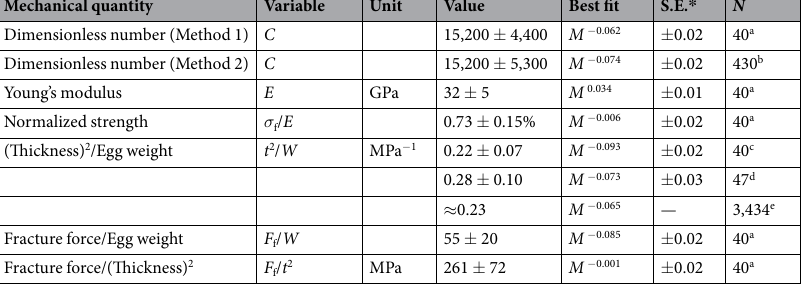
t 2 / W MPa − 1 0.22 ± 0.07